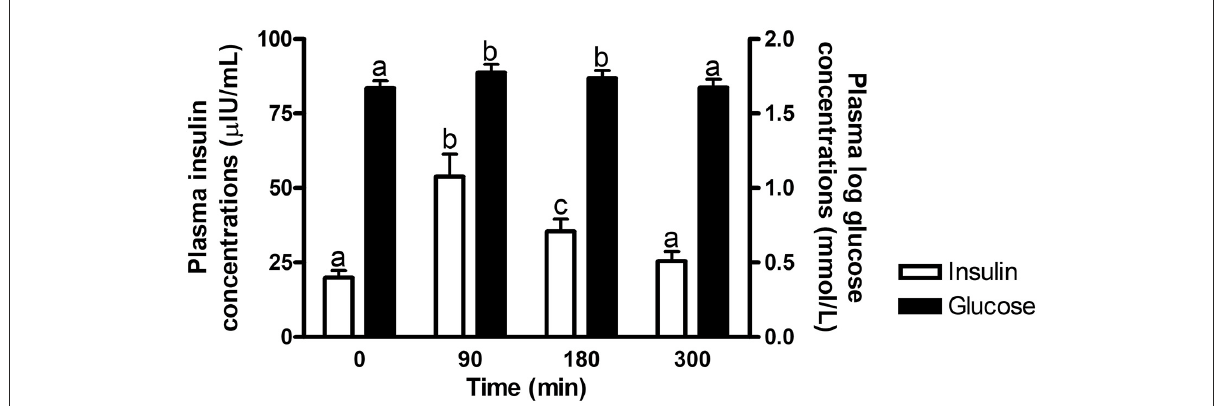
FIGURE1 Plasma glucose and insulin concentrations at times of biopsy. Effect of time on plasma glucose (black bars) and insulin (white bars) concentrations at 0, 90, 180, and 300min post consumption of the treatment pellets in all horses. a,b Different letters indicate differences between timepoints for plasma glucose and insulin concentrations (Effect of time, P ≤ 0.0002). Glucose concentrations were log transformed for analysis. Data presented as least square means ± standard error of the mean.